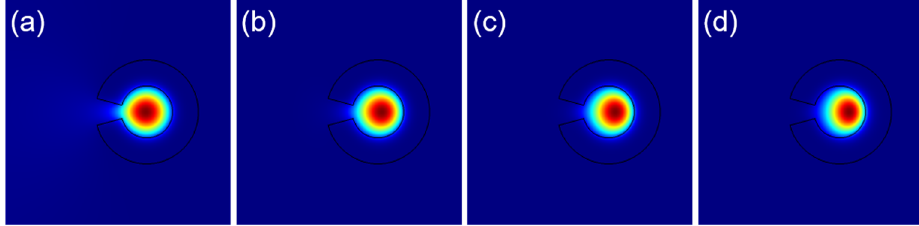
Figure 5. Mode profiles calculated for R 2 = 2R 1 , ρ = 15 μ m and twist rate A = 0 ( a ), 15 ( b ), 20 ( c ) and 25 cm − 1 ( d ).